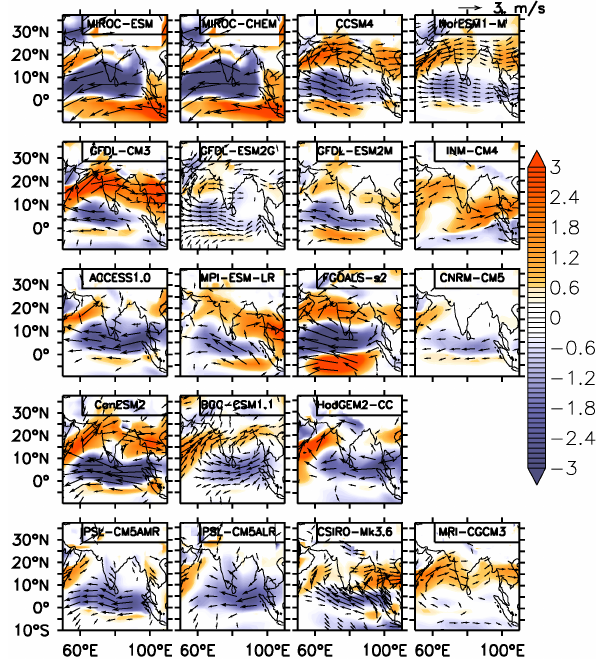
Fig. 12. Difference in wind speed (shading, in ms − 1 ) and direc- tion (vectors) during June–September for the period 2070–2100 un- der RCP-8.5 and 1970–2000 for 19 models under consideration. HadGEM2-ES is not shown as wind data for historic period were not available at the time of the study. Wind vector anomalies are in the direction of the mean flow over the northern parts of India and are opposite to the mean flow over the southern parts of India in most of the